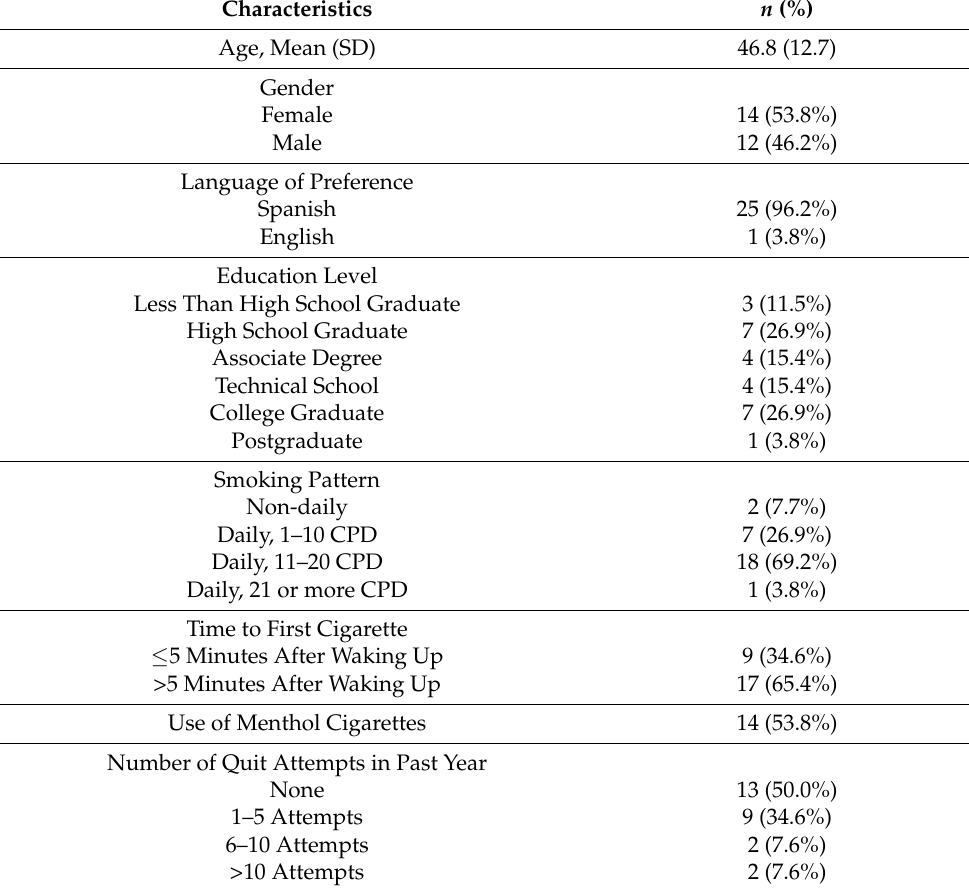
Table 1. Baseline characteristics of participants ( n =